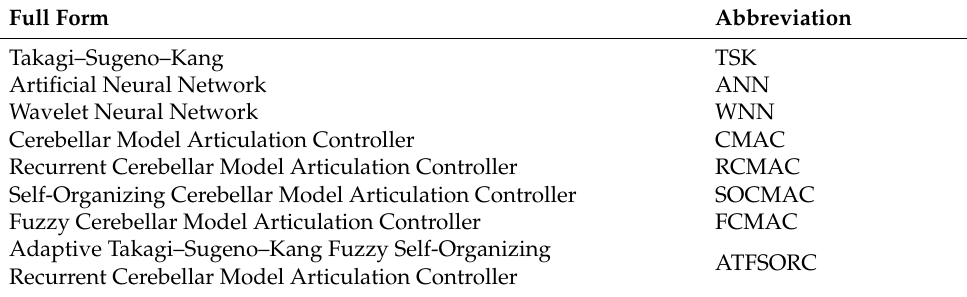
Table 1. Full forms and the corresponding abbreviations used in this